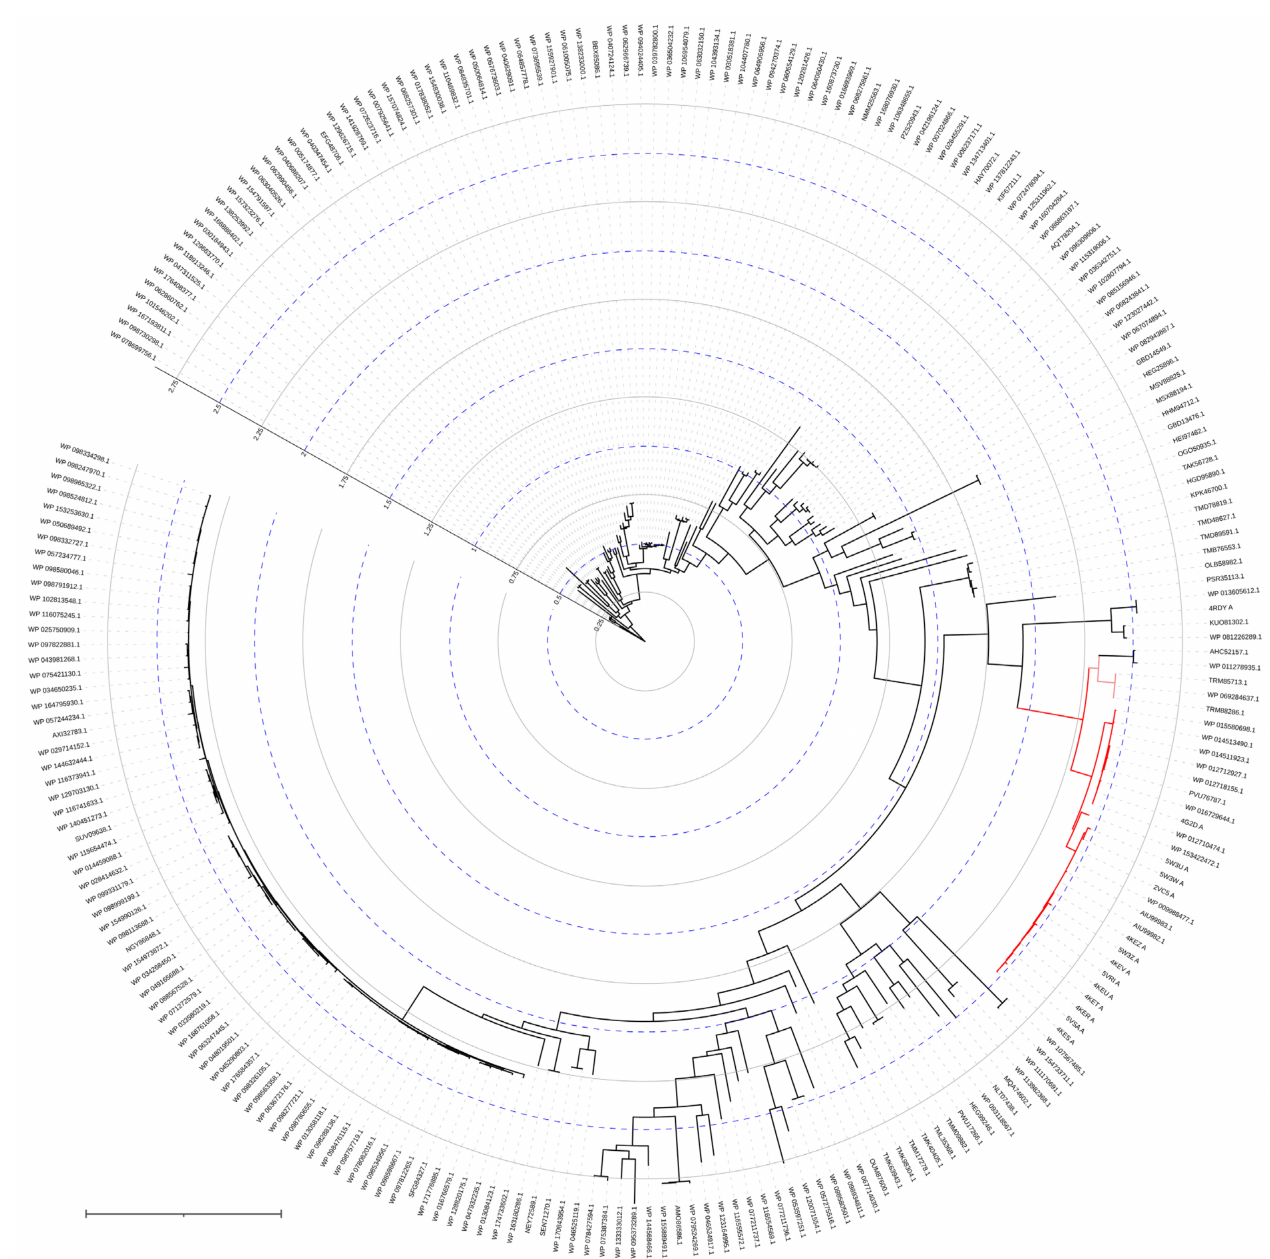
Figure 5. Phylogenetic tree of SsoPox and its homologous enzymes (down to 40% identity). The tree was built as previously with PDB 3UF9 as a reference sequence. Enzymes having high (90–100%) and good (80–89%) identity are highlighted with red and pink,